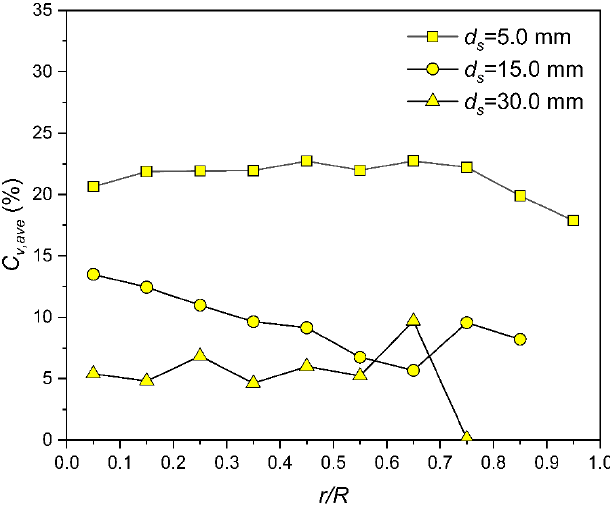
Figure 12. Effects of particle diameter on average SVF ( V mix, 0 = 4.0 m/s, C v, 0 = 5%).